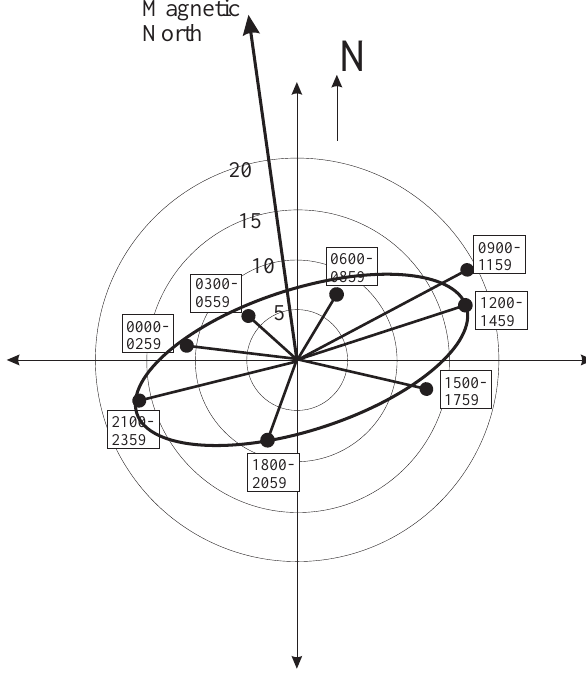
Fig. 7. Average inverse decay vectors plotted as a function of time of day for the summer of